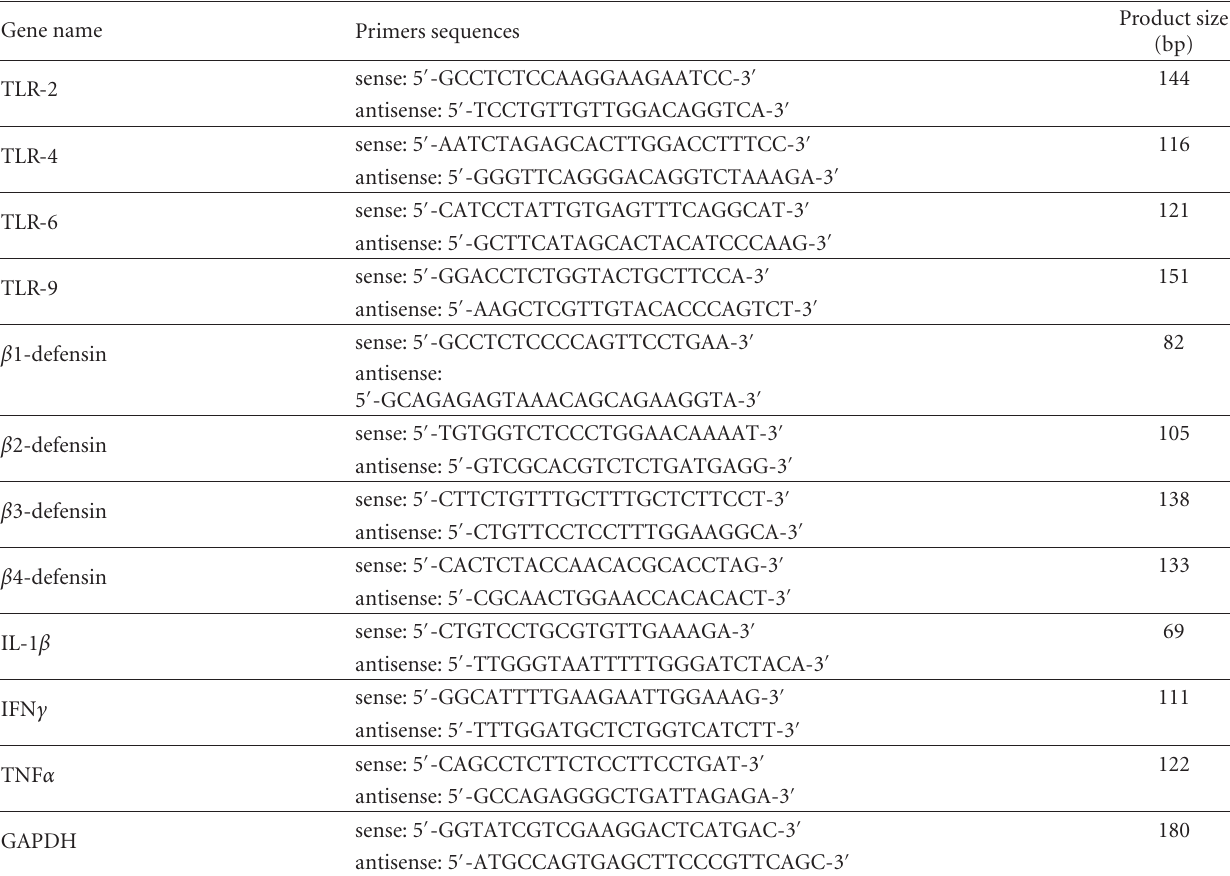
Table 1: Primer sequences used for the q-RT-PCR.